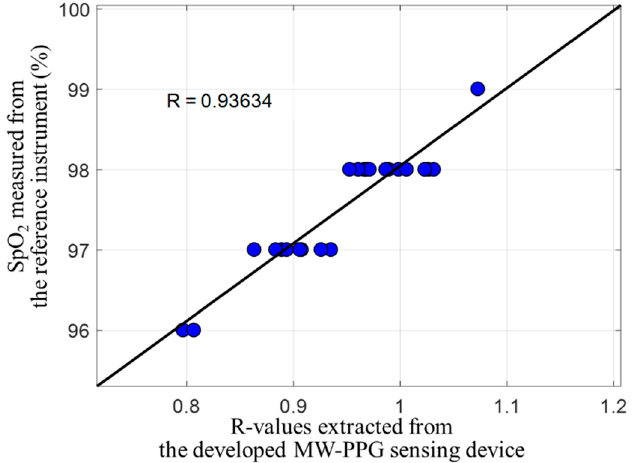
Figure 10. Correlation analysis between SpO 2 and R-values extracted from the MW-PPG sensing device developed.